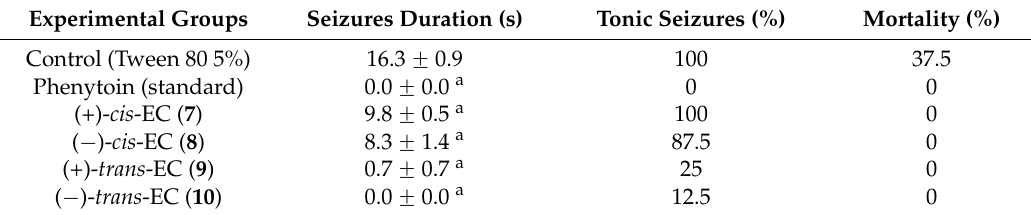
Table 2. Epoxycarvone stereoisomers effect on maximal electroshock-induced seizures test (MES). Experimental